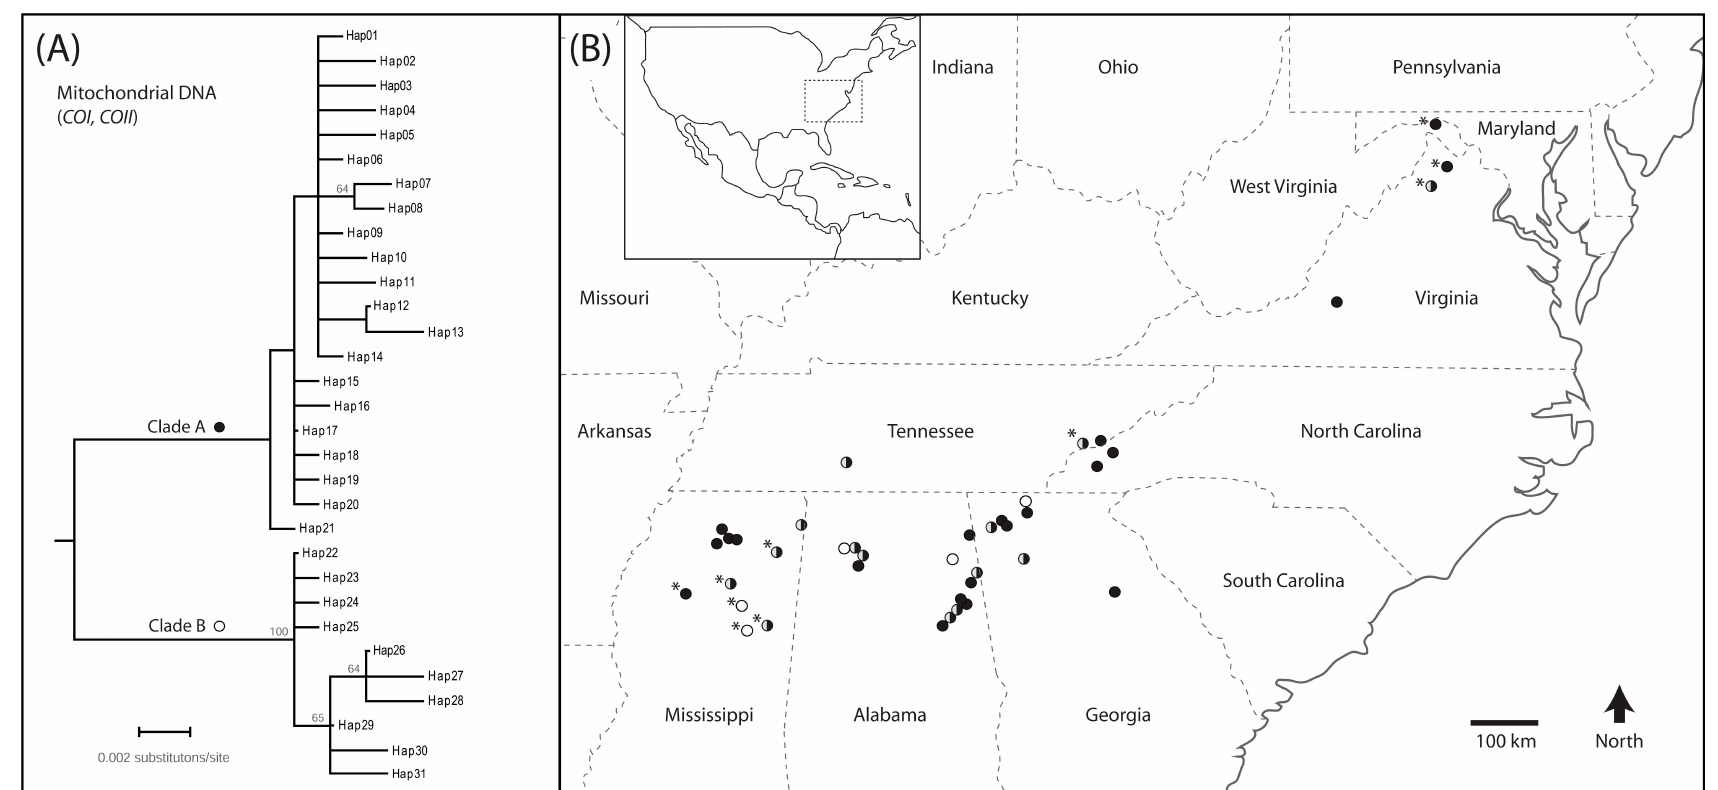
Figure 1. ( A ) Midpoint-rooted maximum-likelihood phylogenetic tree showing relationships among 31 non-redundant mtDNA haplotypes contained within the combined dataset. Numbers on nodes are bootstrap values (only those ≥ 50% are shown). Names of haplotypes are arbitrary; ( B ) Map showing the spatial distribution of 46 Odontotaenius disjunctus sampling sites (circles) across the southern Appalachian Mountains and surrounding areas, including northern Mississippi (see Table 2 for coordinates, and sample sizes per clade per site; asterisks indicate sites sampled by Swanson [35]). Different shading is used to represent the spatial distributions of clade A (solid) and clade B (open). Wherever members of both clades were sampled from the same site, the symbol is half solid and half open. Inset: map showing location of study area within the continental U.S. (dashed box).